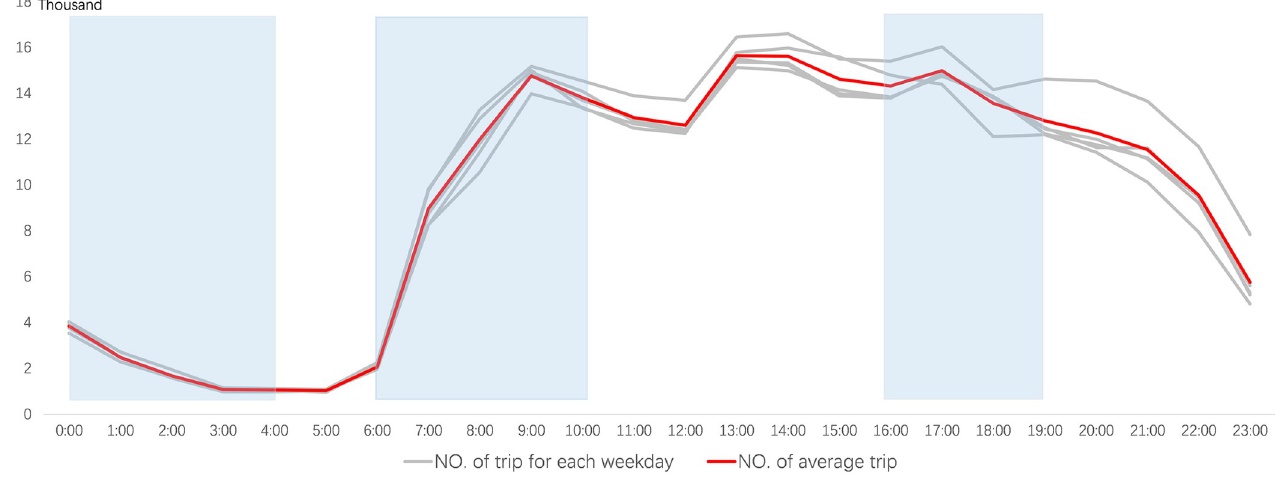
Fig 2. Number of trips per hour on each